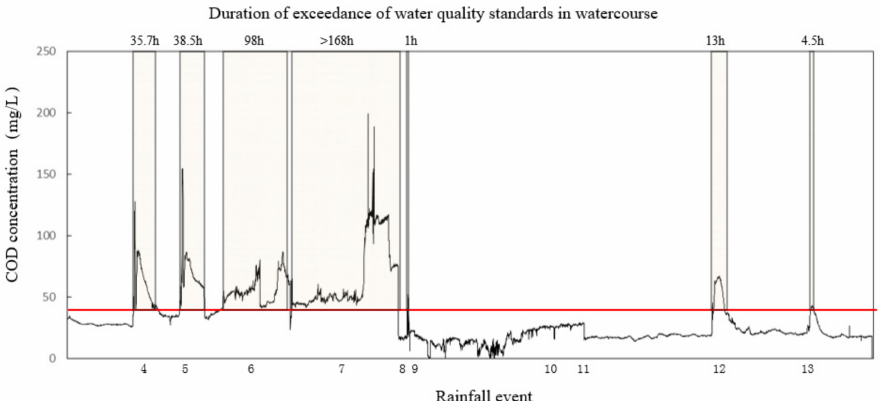
Figure 7. Impact of rainfall on river water quality (red line is the surface water Class V standard for COD, 40